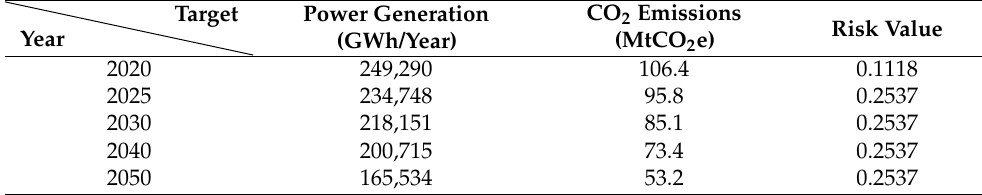
Table 3. The trajectory of power generation, CO 2 emissions and reasonable risk